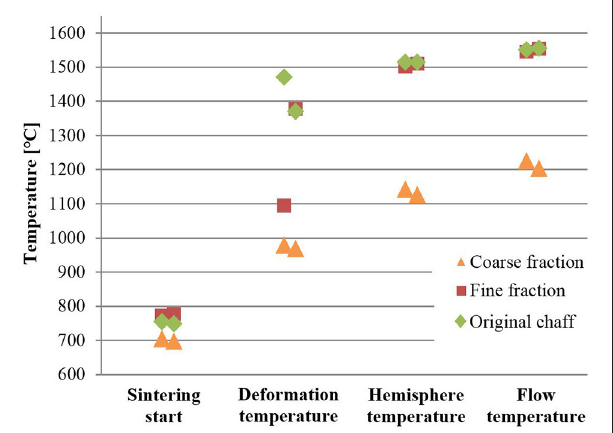
FIGURE 3 | Characteristic temperatures of the ash melting behavior of different fractions (double determination).